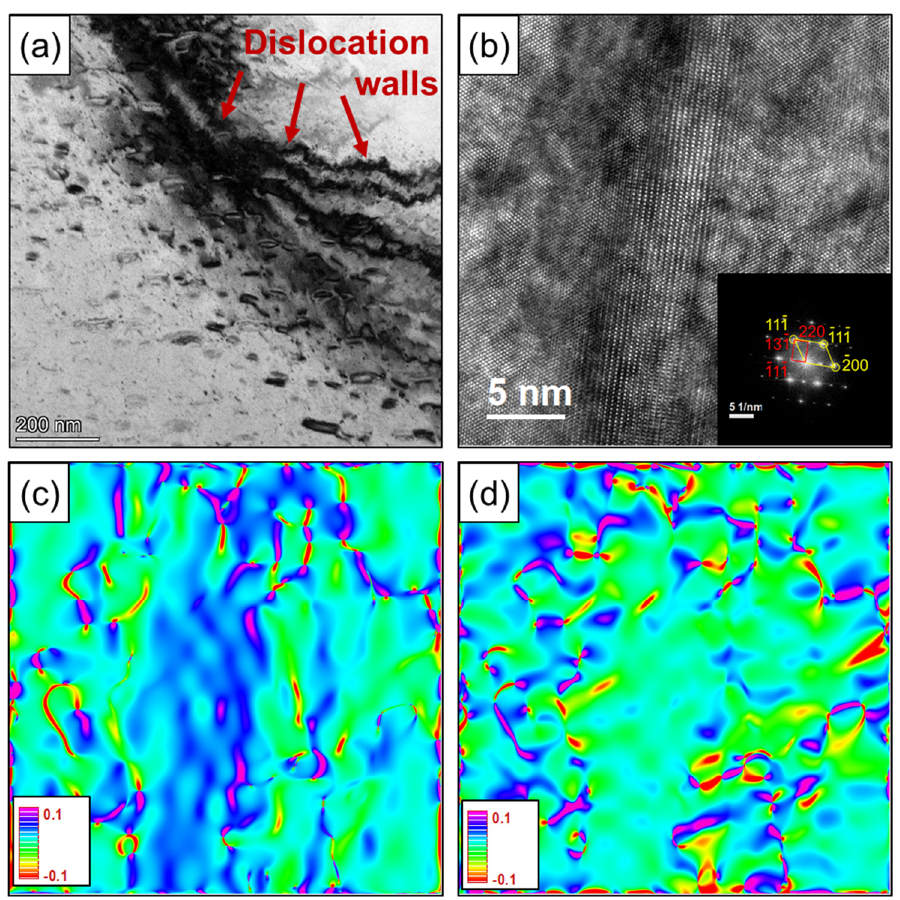
Figure 8. High-resolution TEM image of the 5# sample after compressive tests: ( a ) the interaction between dislocations and the γ ’ phase precipitates, ( b ) the high-resolution TEM result, ( c , d ) GPA result along the (cid:4670)111(cid:4671) and [ 2 00(cid:4671) direction, respectively.